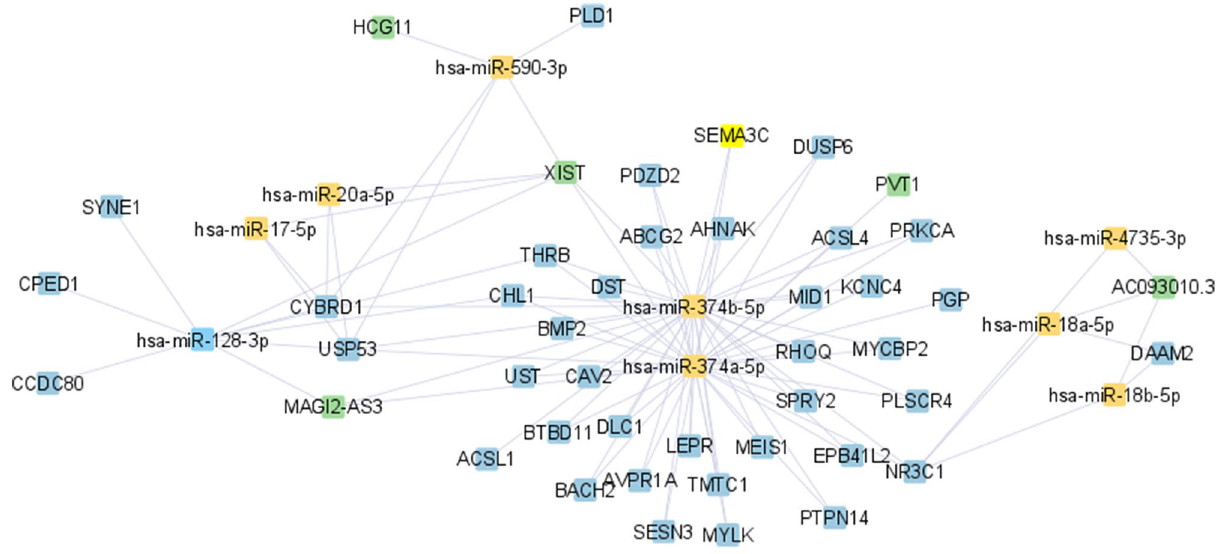
Figure 3. ceRNA network for stage III BC, was constructed by the Cytoscape tool 23 .